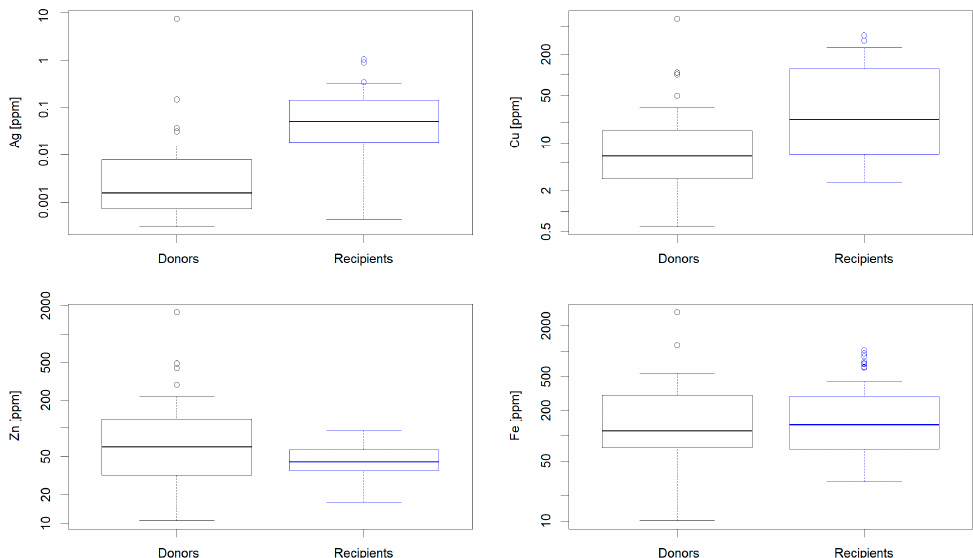
Figure 1. Ag, Cu, Zn, and Fe concentration in donors (black) and recipients (blue) livers. These concentrations are compared with rectangle boxes corresponding to the 1st and 3rd quartiles, thick lines denote the median, thin horizontal lines mark the min–max range, and circles represent outliers according to Grubb’s test. The value of 0.25 ng per liver sample was assigned to samples with the Ag signal below the detection limit.